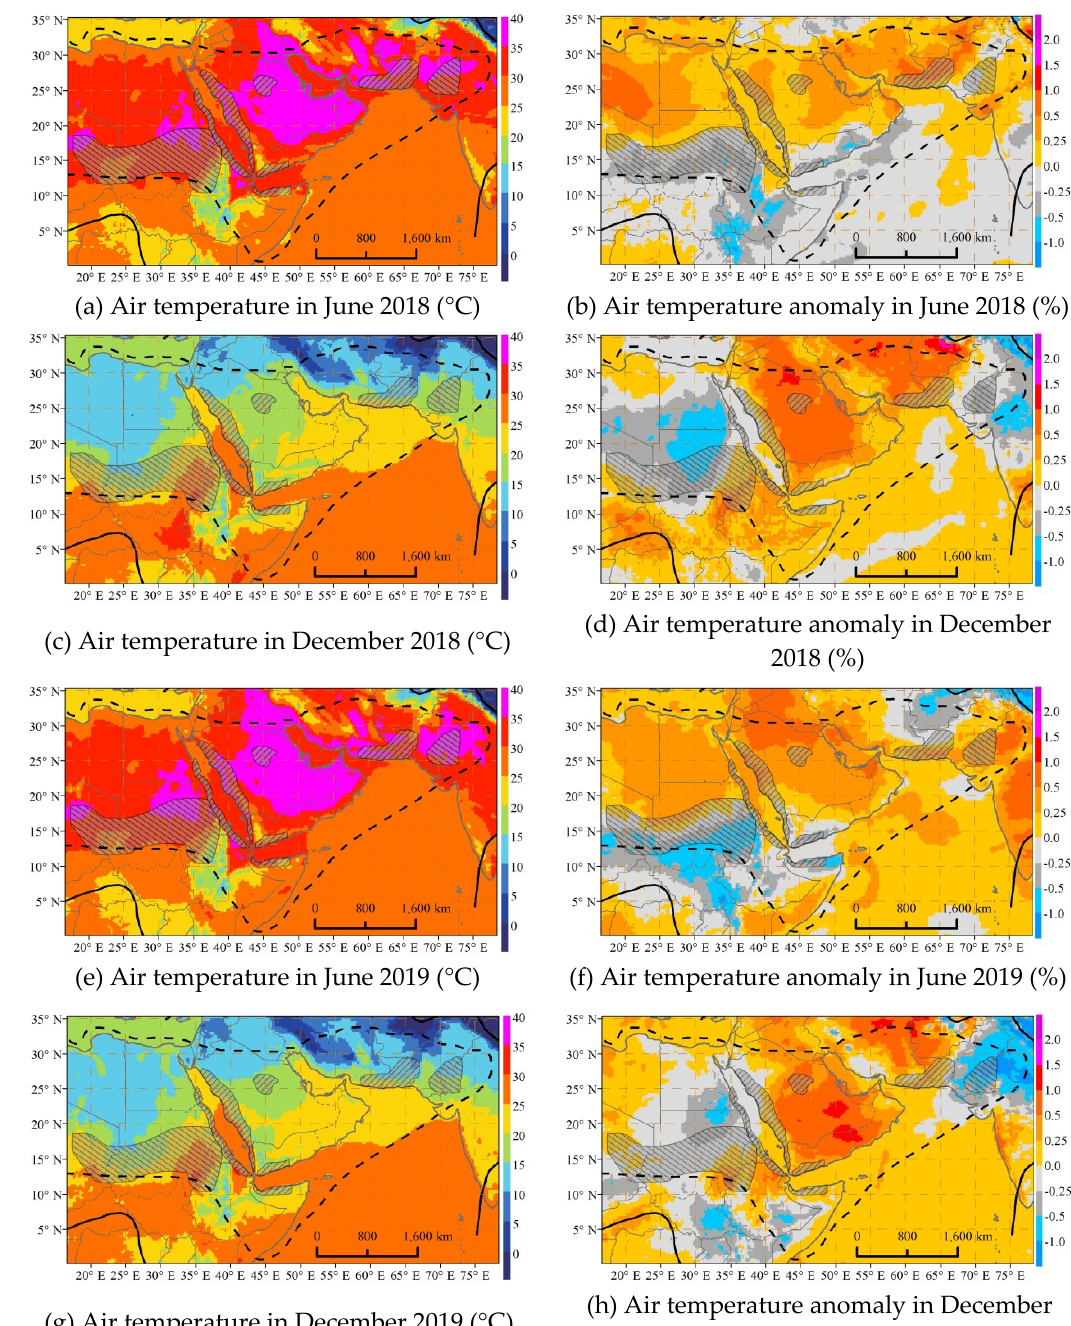
Figure 3. Air temperature and its anomaly over part I of the study area during 2018–2019. In order to examine the variation trend of the air temperature during 2018-2019, the monthly average of the air temperature and its percentage ratio compared to the past dec- ade across the locusts breeding area, including the Empty Quarter and the southwest Iran, in 2018 and 2019 were calculated and graphed as Figure 4. According to this Figure, the months from April to October have a favorable air temperature (25~30 ℃ ) for the breeding and migration of the locusts, as well as the development of the vegetation, during 2018– 2019. Additionally, the study area has experienced a similar or higher air temperature in most of months compared with the averaging air temperature in the past ten years under the influence of global climate change. In 2018, only one month (January) out of twelve has a slightly lower air temperature percentage ratio than 100%, and the other monthly air temperature values in the months from February to December are close to or higher than the averaged air temperature, especially in the February and March 2018, with the air temperature percentage ratios greater than 106.0%. In 2019, the monthly air tempera- ture percentage ratios in February, March and April are lower than 100%, while the air temperature s of the other nine months are greater than or equal to the air temperature norms in the past ten years. It is likely that a favorable and higher air temperature in the study area promotes and accelerates desert locust population maturation, the production of multiple generations and locust swarm migration, especially during the spring period. F igure 4. Air temperature and its percentage ratio over part I of the study area during 2018 – 2019 3.1.3. Land Surface Soil Moisture In general, the desert locusts tend to breed in and migrate between their summer and winter/spring breeding areas, such as the Red Sea coast, interior of the Saudi Arabia, South Sudan, South Iran and the Indo-Pakistan border, and they migrate between the regions with continuous rainfall. The continuous heavy rainfalls during the latter half of 2019 and